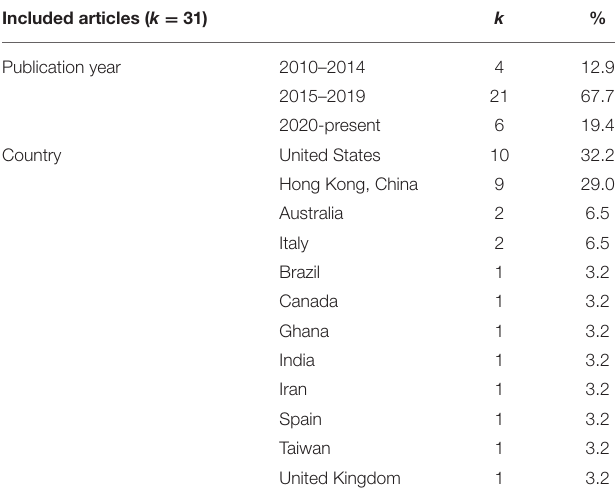
TABLE 3 | Publication year and country of origin of included studies. Included articles ( k = 31) k